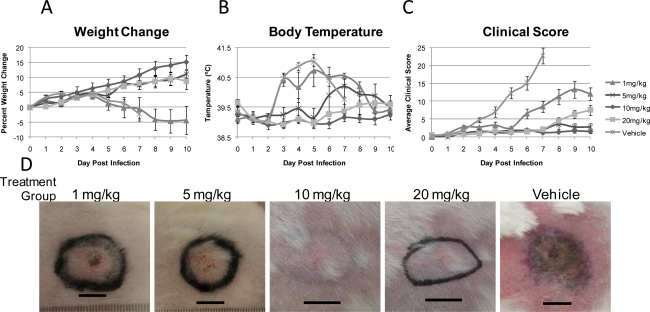
Clinical observations for evaluation of minimum dosage of CMX001 to provide protection from RPV disease. Animals were dosed at concentrations and schedules as outlined in Table 1. (A) Average weight change from weight at day of infection. Negative values indicated weight loss. (B) Average body temperatures. (C) Average clinical scores. (D) Pictures of primary lesions from representative animals at 7 dpi. Bars represent 1 cm. Black circles denote site of intradermal inoculation.